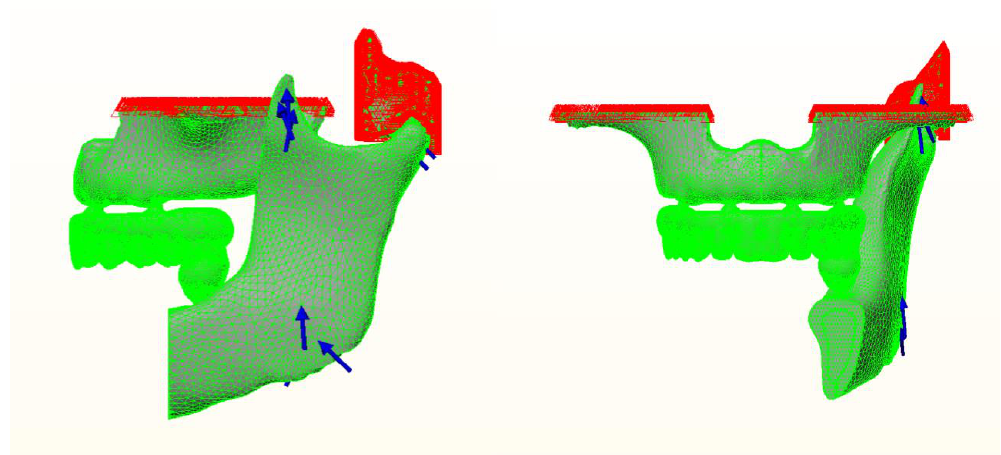
Figure 3. Boundary conditions and force directions used in the analysis.